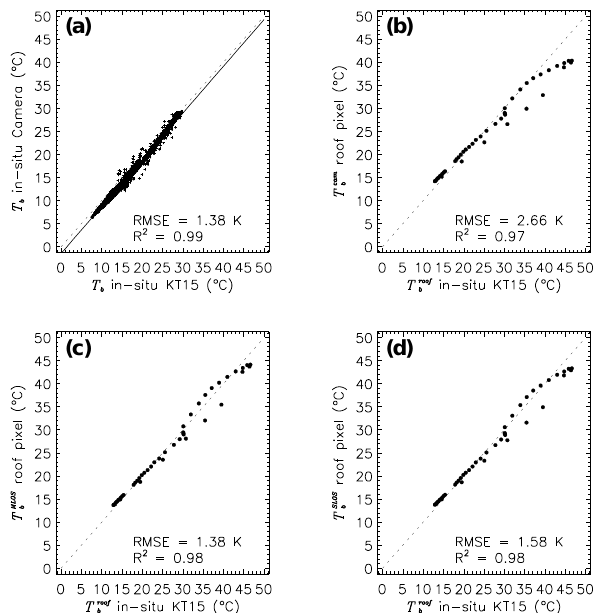
− b − T SLOS at 12:00 b b